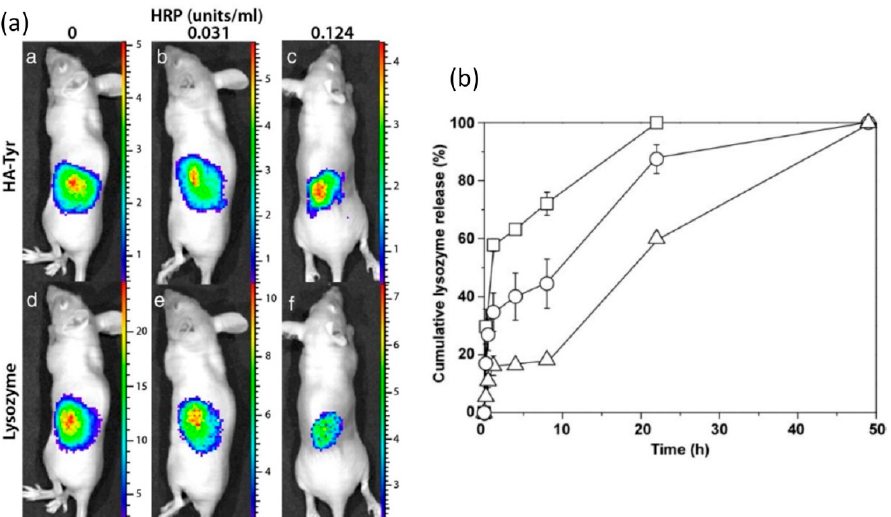
Figure 6 . ( a ) In vivo formation of HA–Tyr hydrogels containing lysozyme. H 2 O 2 concentration was fixed to 728 μ M while the concentration of HRP increased from 0 (a,d) to 0.031 (b,e) to 0.124 (c,f) U/mL. The upper row (a–c) shows the locations of HA–Tyr and the lower row (d–f) shows the location of lysozyme. Color bar has the unit of 10 9 photons/s/cm 2 /steradian. ( b ) Cumulative release of lysozyme from HA–Tyr hydrogels in the presence of 2.5 U / mL of hyaluronidase. The hydrogels were formed with 0.124 U/mL of HRP and ( □ ) 473, ( ○ ) 582 and ( △ ) 728 μ M of H 2 O 2 ( n = 2, mean ± S.D.). From [56].